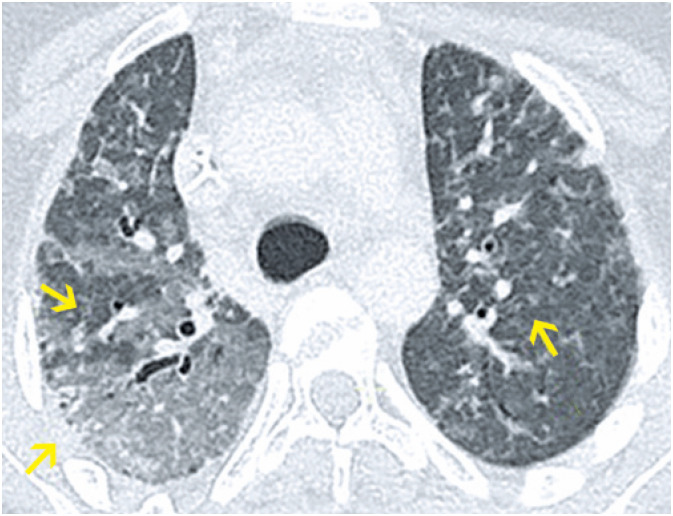
Paciente do sexo feminino, 15 anos, com quadro de dispneia súbita. Antecedente pessoal: imunossuprimida. Tomografia computadorizada (axial): opacidades em vidro fosco e de micronódulos peribroncovasculares bilaterais, acompanhadas de pequenos focos de consolidação irregular. Diagnóstico confirmado por lavado broncoalveolar